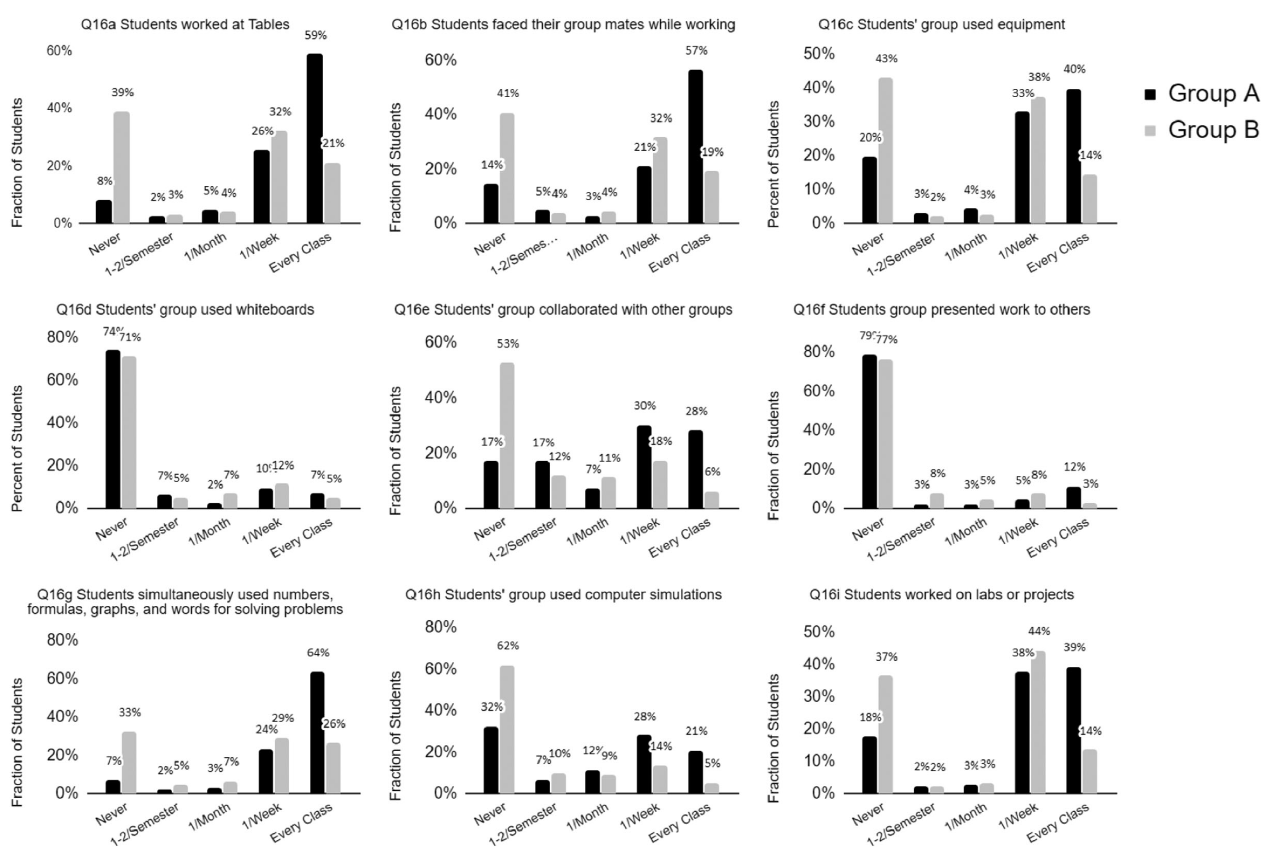
FIG. 2. Histograms of group work details for groups A and B. Question 16 probed students on their group work and asked the frequency of different types of classroom practices throughout their first semester of introductory